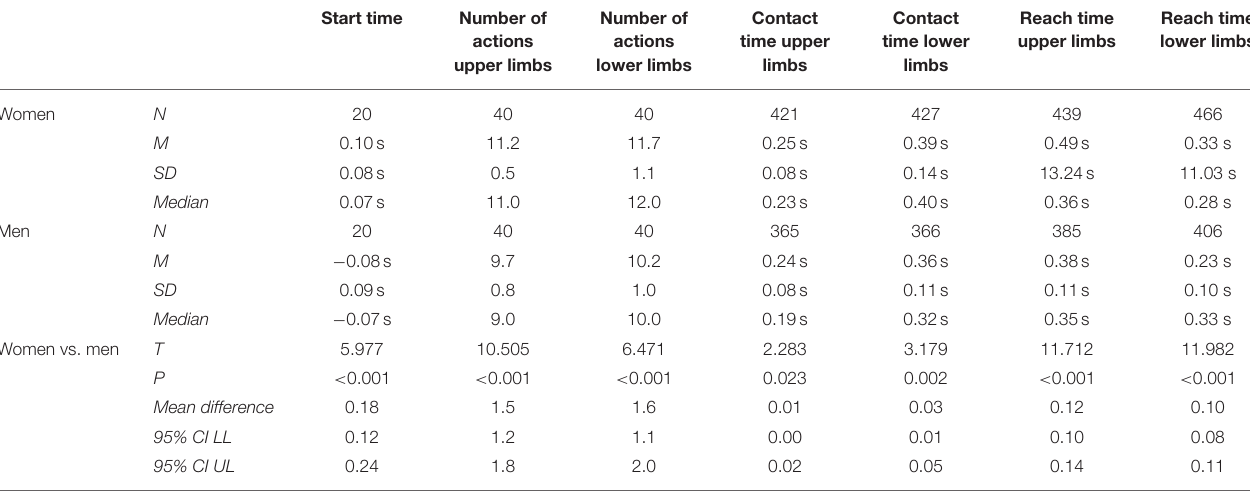
Start time Number of